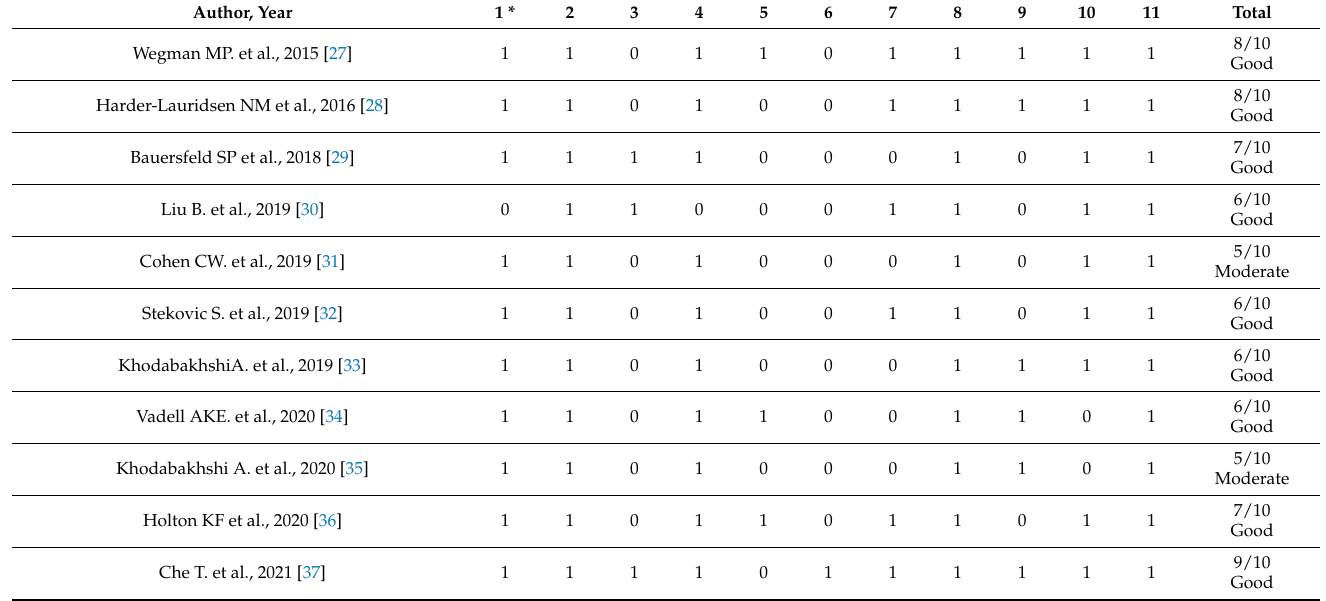
Table 2. Study of the methodological quality of the RCTs through the PEDro Scale.